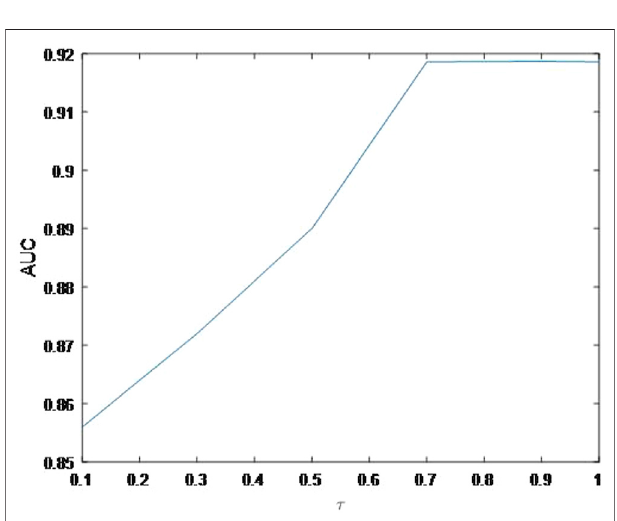
FIGURE 6 | Variation of the AUCs with the various settings of τ .